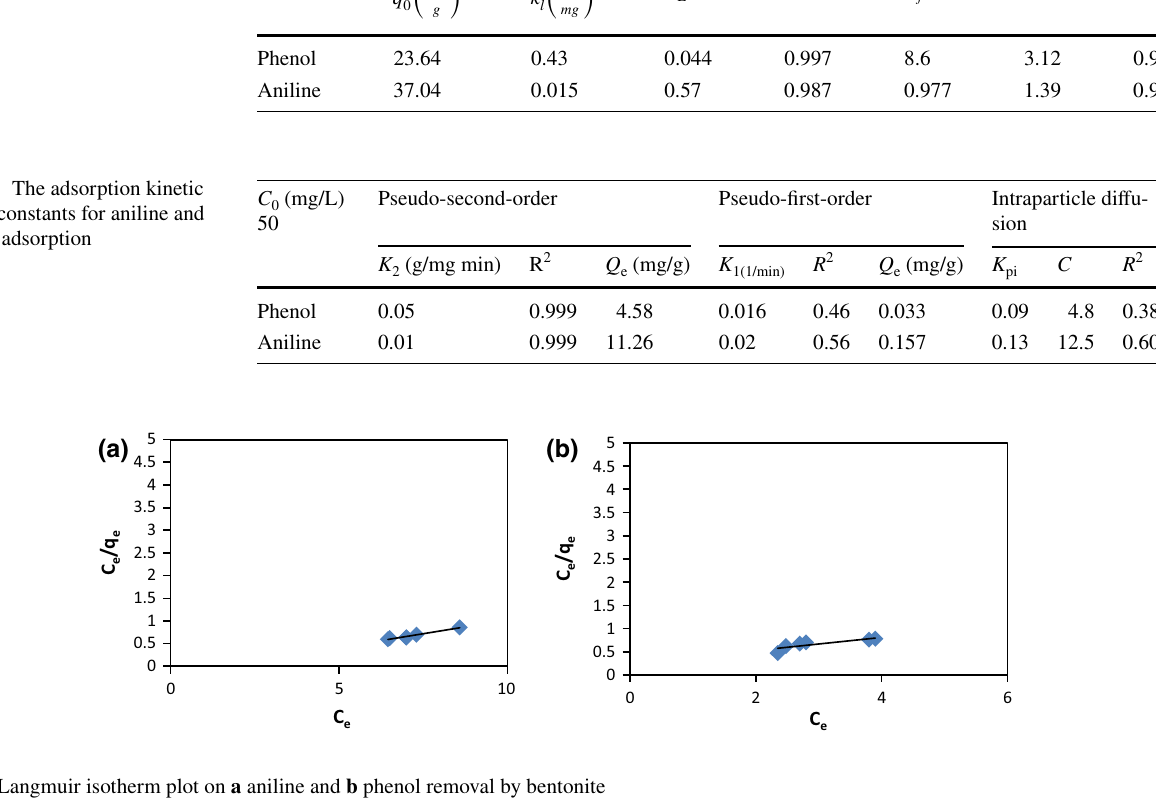
Table 6 The adsorption isotherms constants for aniline and phenol adsorption